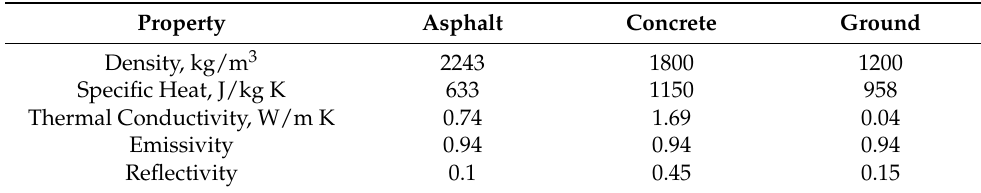
Figure 4. Mesh around the pavement geometry. Table 1. Material